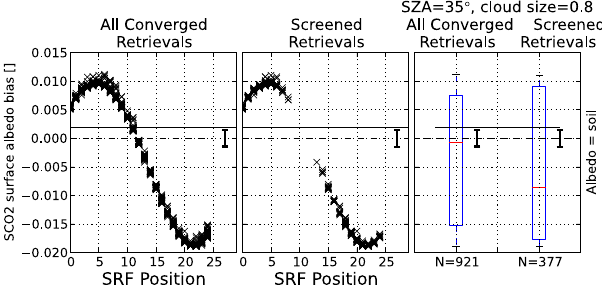
Figure 9. Bias in retrieved SCO2 albedo, with the same layout as Fig.